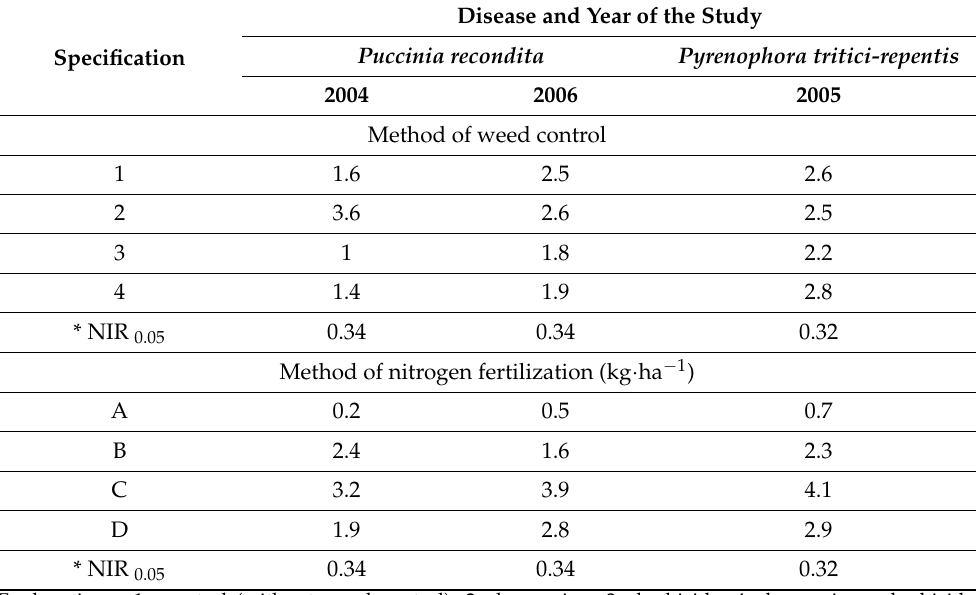
Table 1. Occurrence of brown rust in 2004 and 2006 and Pyrenophora tritici-repentis in 2005 (%) depending on nitrogen fertilisation and weed control. Reprinted from reference [88].